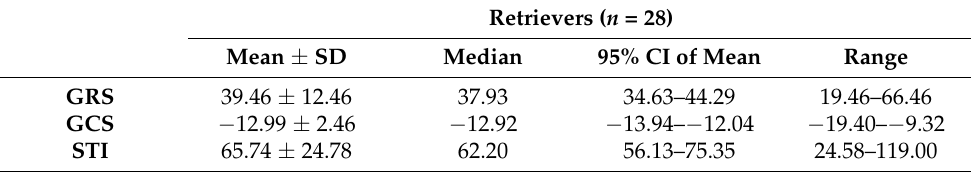
Table 4. Two-dimensional speckle-tracking echocardiographic parameters of clinically healthy